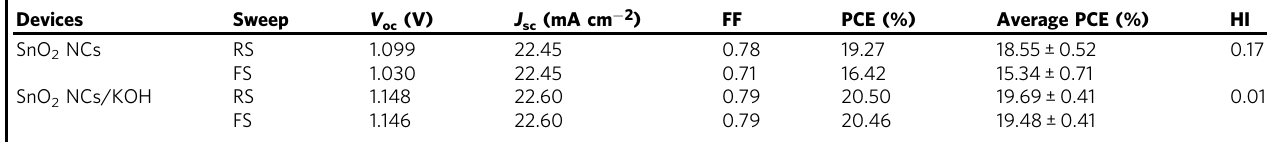
Table 1 Parameters derived from the J-V curves of the champion rigid PSCs based on different SnO 2 substrates